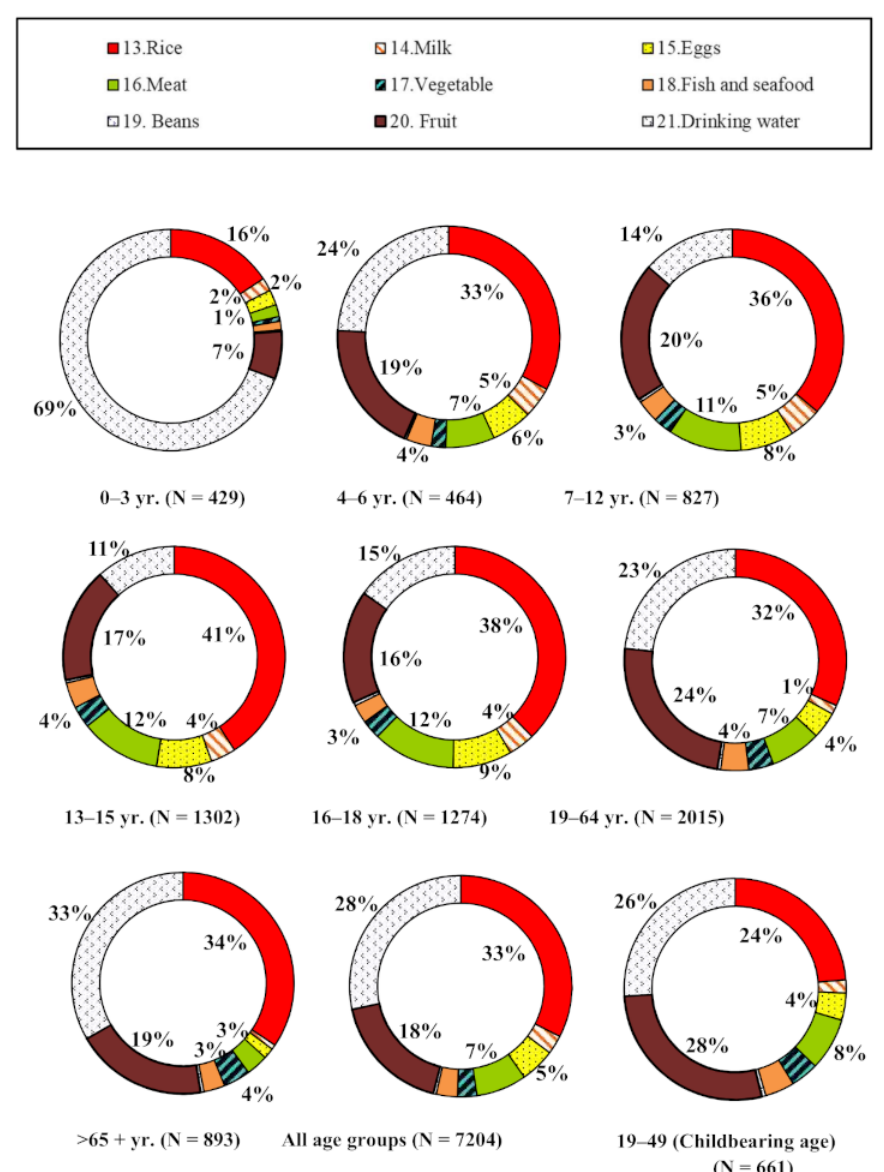
Figure 3. The contribution percentage (%) of the mean consumption rate for 9 additional food consumption items in specific age groups, the whole population, and women of childbearing age,